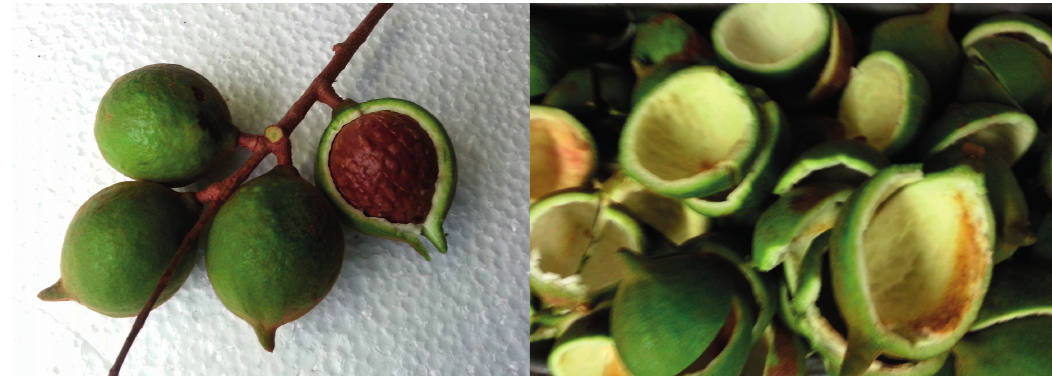
Figure 1. Macadamia ( Macadamia tetraphylla ) nuts ( left ) and skin ( right